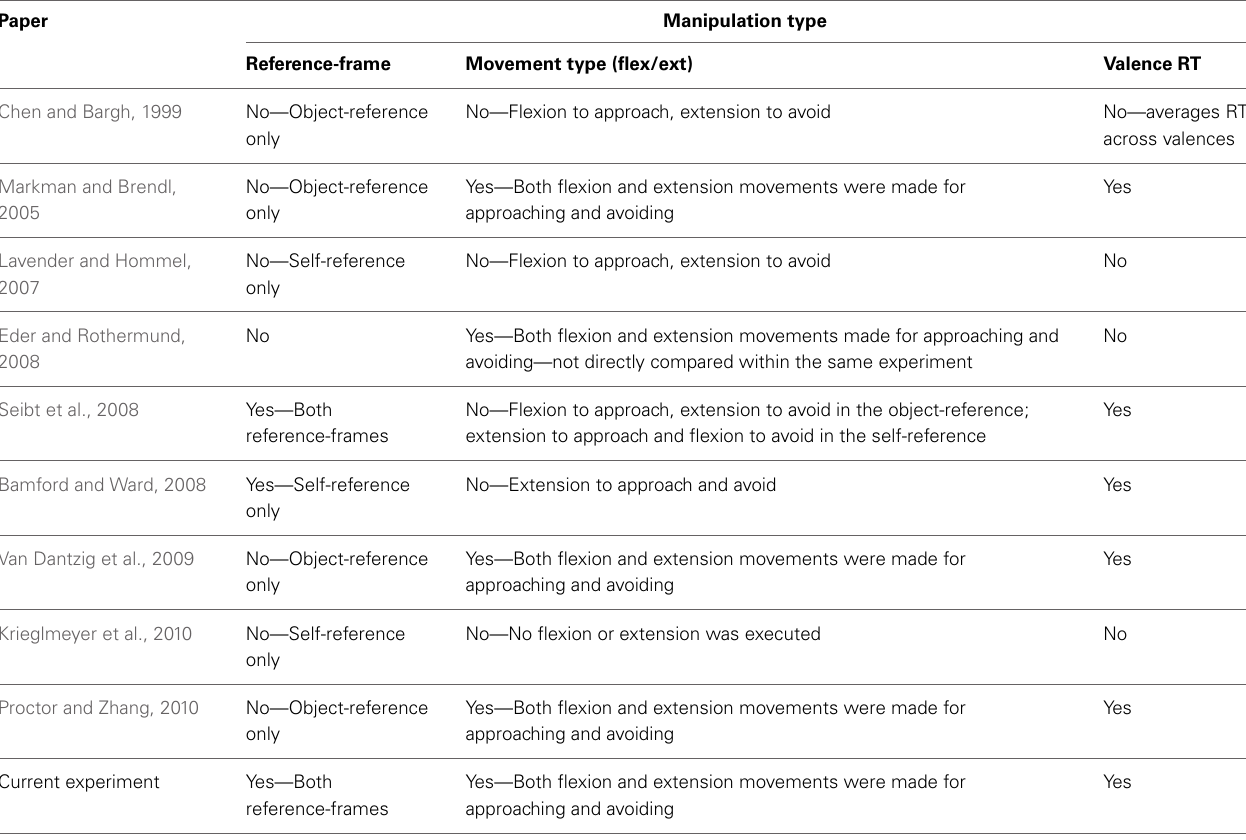
Table 1 | Overview of studies supporting the muscle-specific vs. common-coding